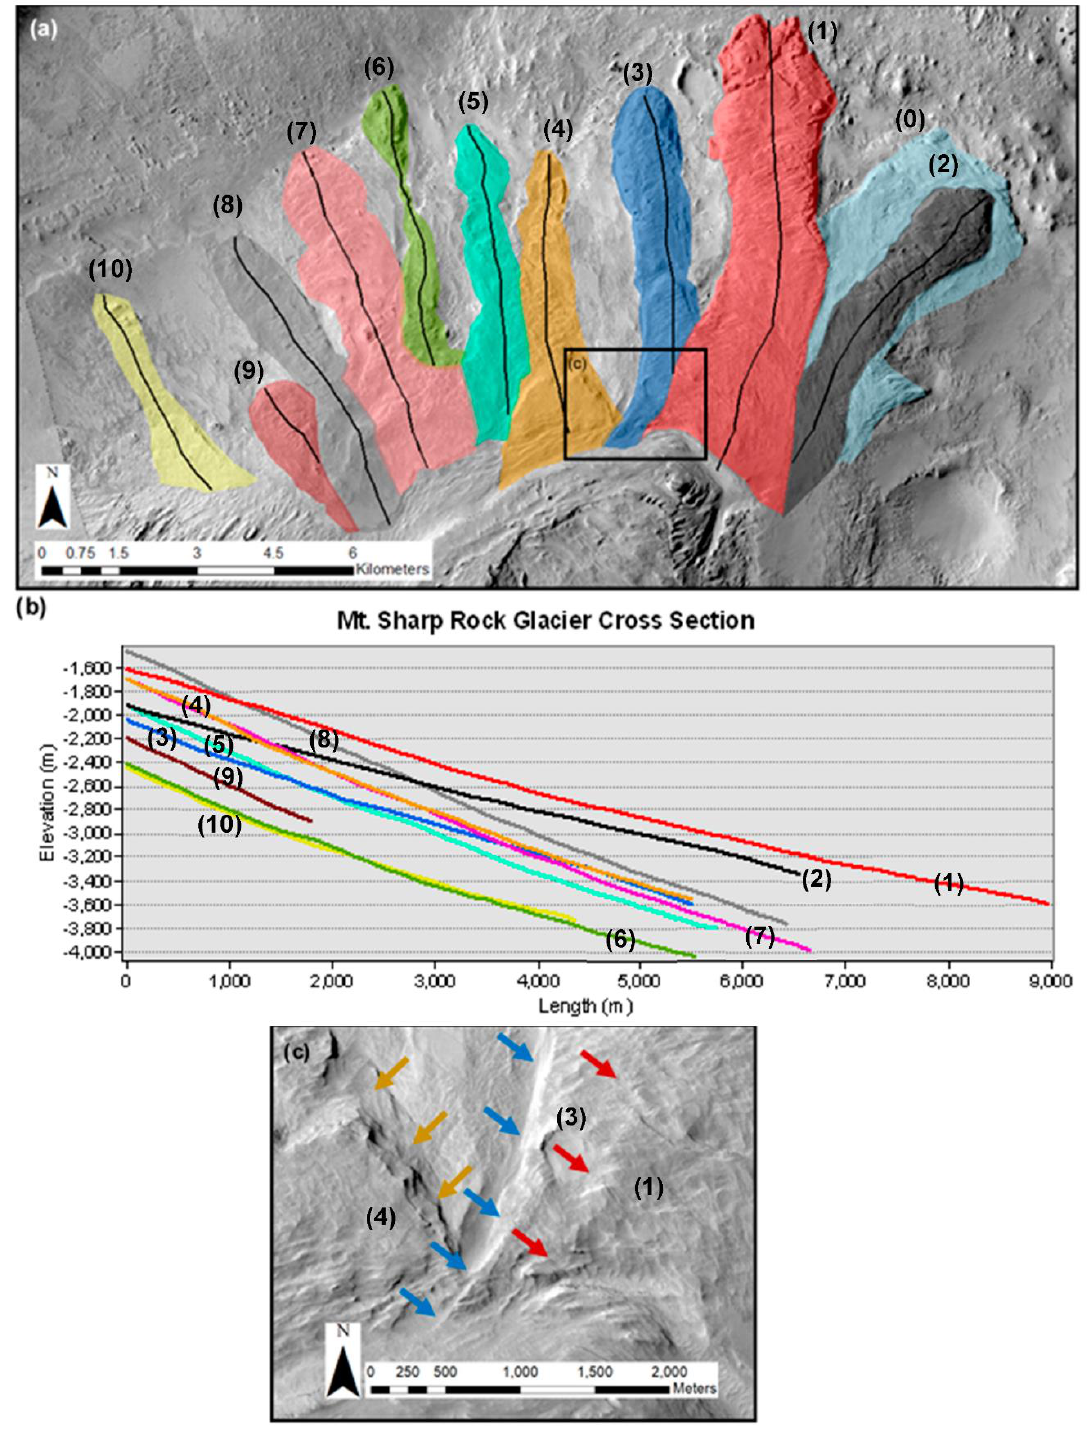
Figure 12. ( a ) Mount Sharp Rock Glacier complex with lobes and central traverse lines identified. Blue (3) lobe (right) is highly degraded and mantled and therefore not included in this analysis. Scarp in the Bu unit of LeDeit et al. [37] occurs at the upper edge of the orange (4), blue (3) and red (1) lobate forms. Boxed area is context location for [c]; ( b ) profiles down the center transverse of the ten lobate features deposits located on the north face of Mount Sharp (Figure 1d). No vertical exaggeration: ( c ) overprinting lobes, red (1) lobe (Red Arrows) overlies the blue (3) lobe (Blue arrows) that overlies orange (4) lobe (orange arrows). CTX image: G01_018788_1754_XN_04S222W; background image credit: